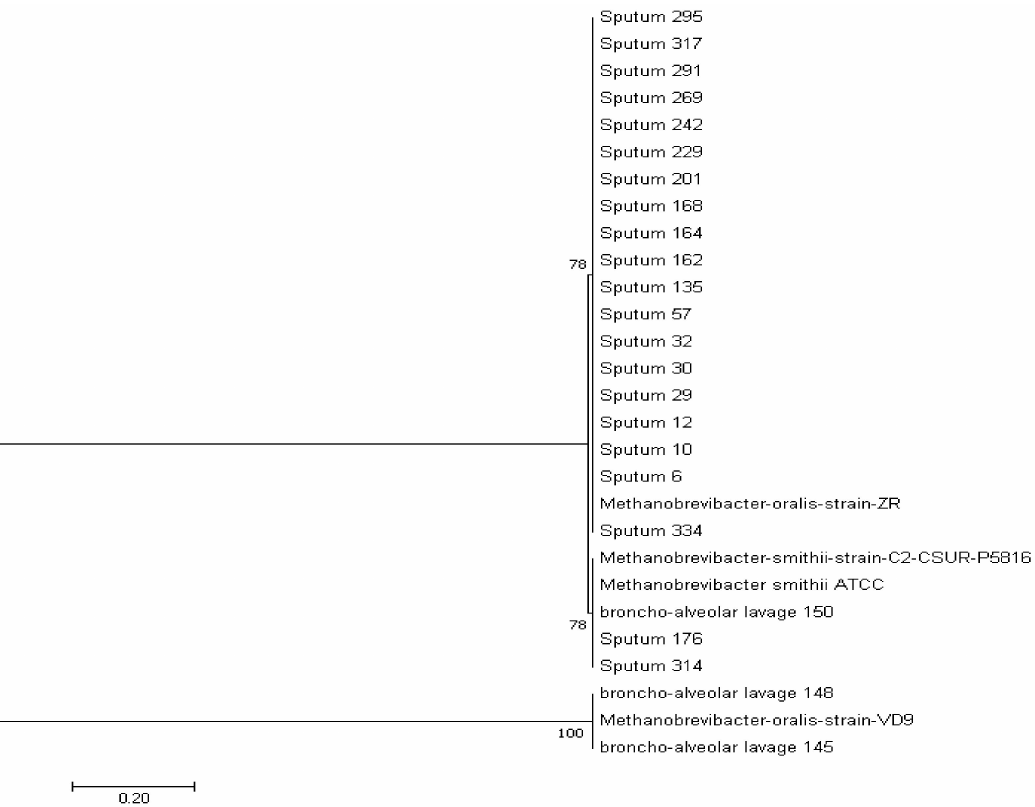
Figure 2. Archaeal 16S rRNA gene sequence-based phylogenetic tree illustrating the phylogenetic position of all the methanogens’ positive sequences relative to other phylogenetically close neighbors. Only bootstrap values > 65% are indicated at